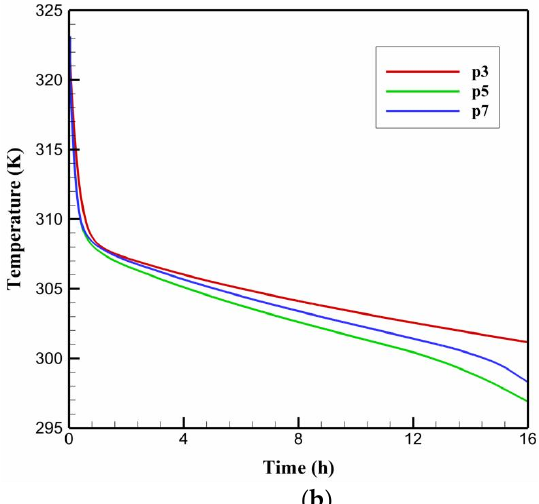
Figure 7. The time-wise variation of ( a ) liquid-fraction profile, and ( b ) average temperature for the PCM solidification with tube arrangements of P3, P5, and P7.